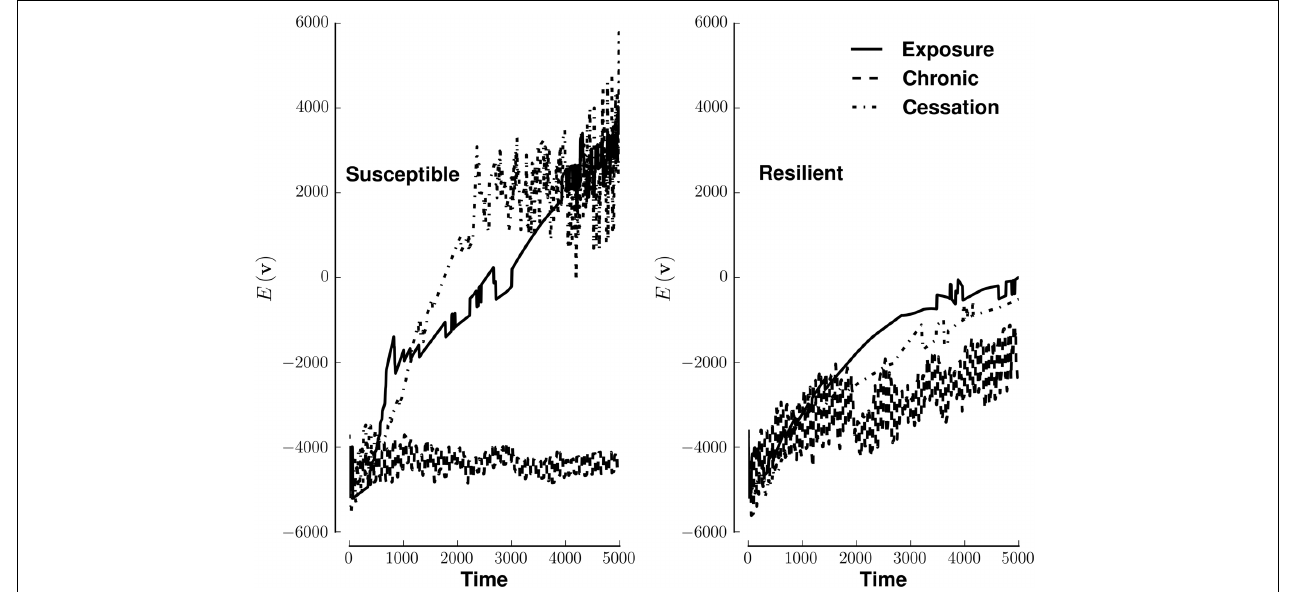
FIGURE 5 | Energy of network activity in the face of various stimulus- rewardpatterns. Leftpanelshowsthestabilityofasusceptiblenetworkwhen stimulated by exposure (solid line), continuous use (dashed line), or cessation